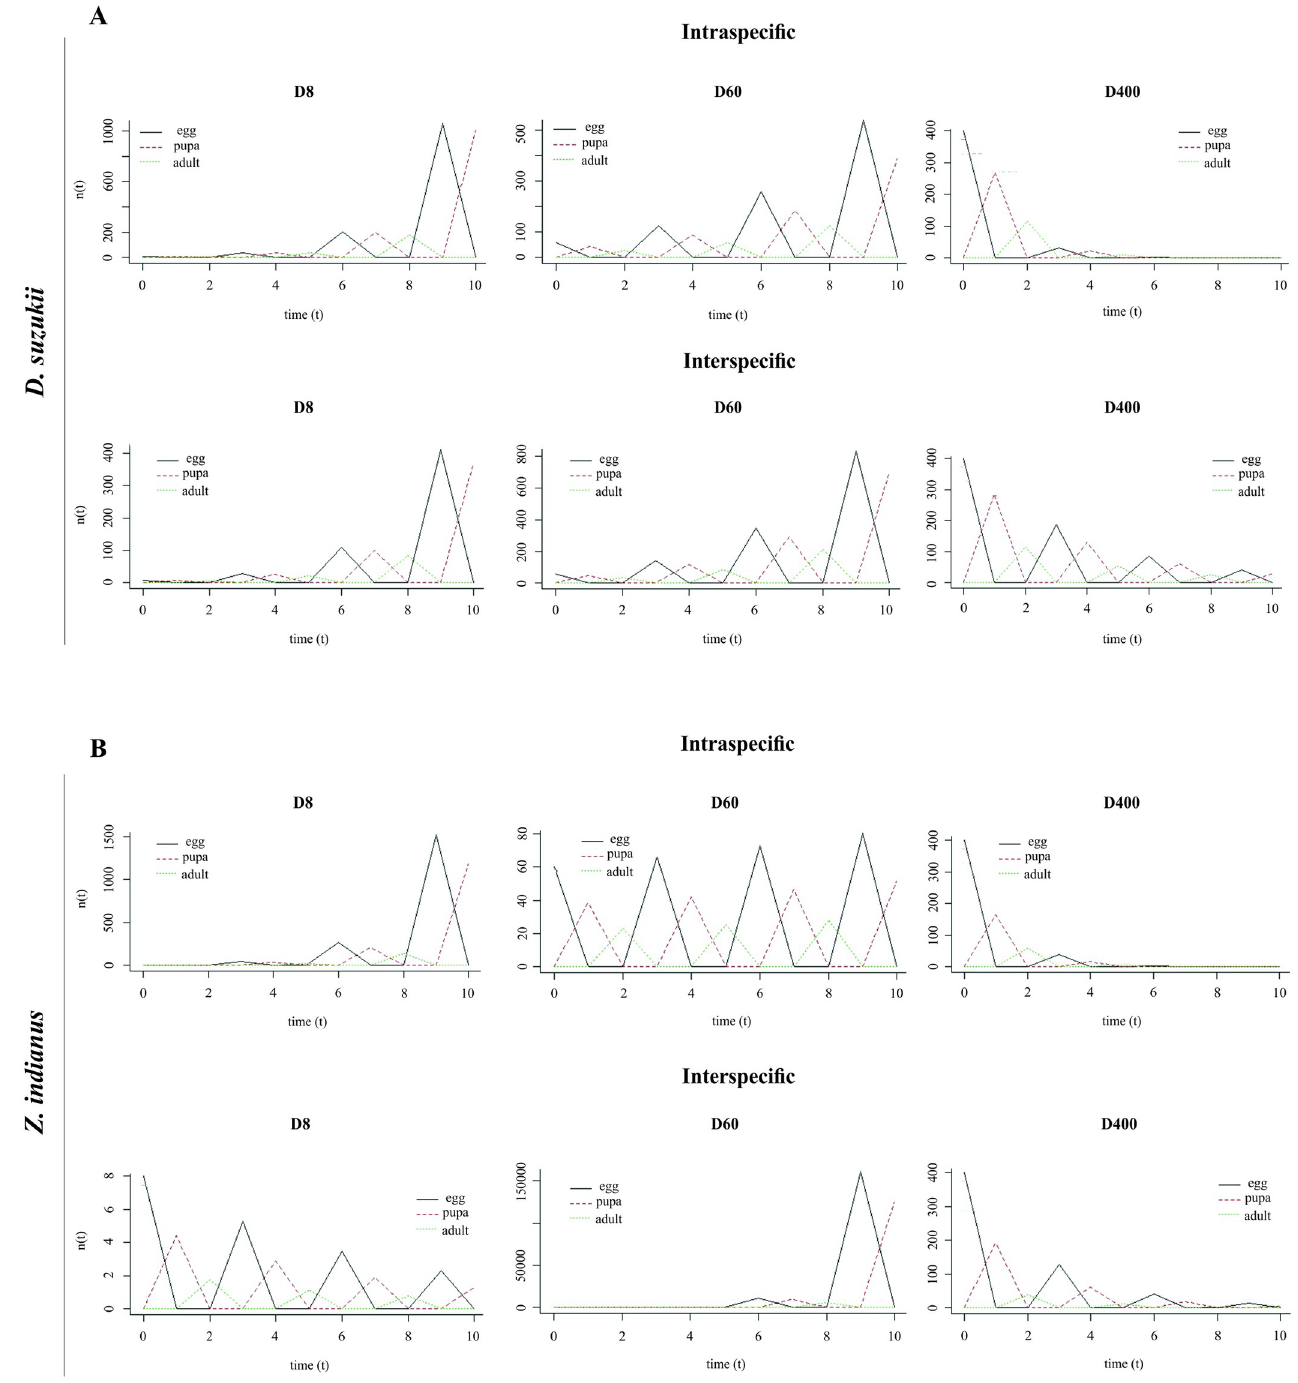
Fig 5. Leslie matrix simulations showing population sizes for life stages of Drosophila suzukii (A) and Zaprionus indianus (B) from intra and interspecific combinations in scenarios of low (D8), moderate (D60), and high (D400) densities.